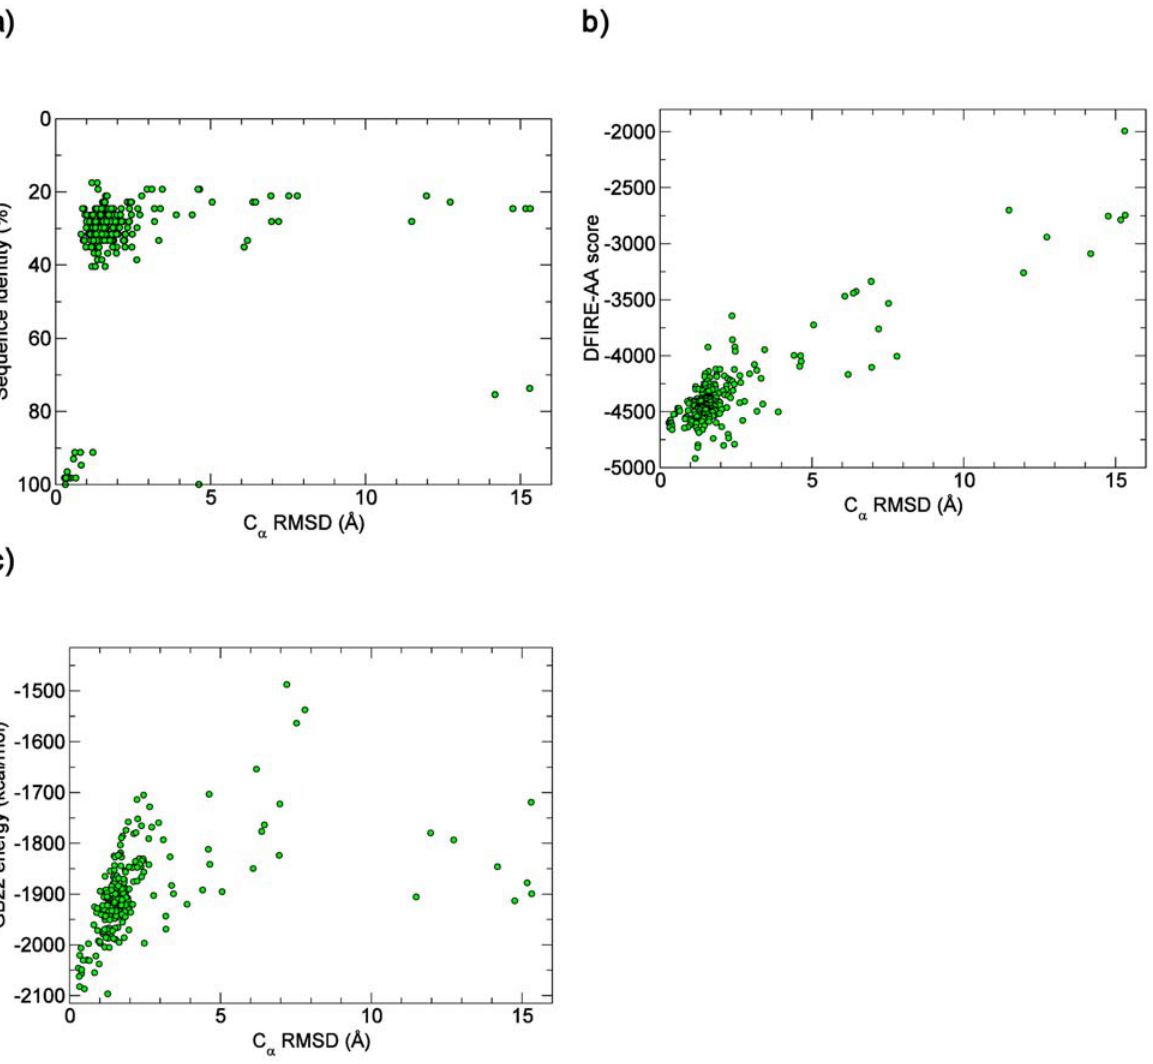
Figure 6. Comparison of various homology model quality criteria against structure accuracy as measured by C a , root mean squared deviation (RMSD) for the a -spectrin SH3 domain (PDB ID: 1SHG): sequence identity (a), DFIRE-AA score (b), and GB22 energy